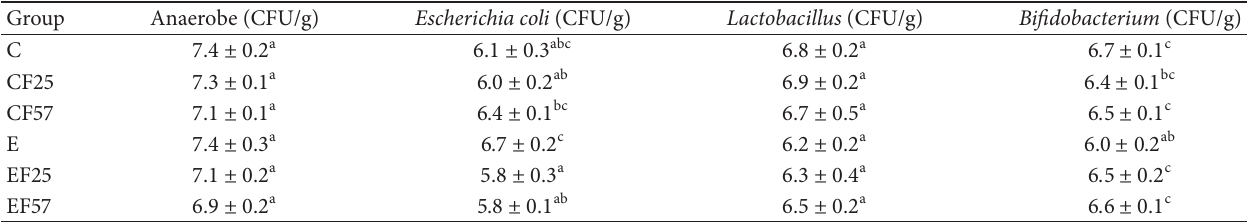
Table 9: Effects of fish oil on fecal microbiota composition in rats under long-term ethanol feeding 1,2,3